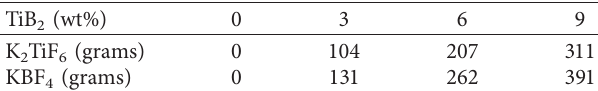
Figure 1: Stir casting furnace. Table 3: The calculated weights of inorganic